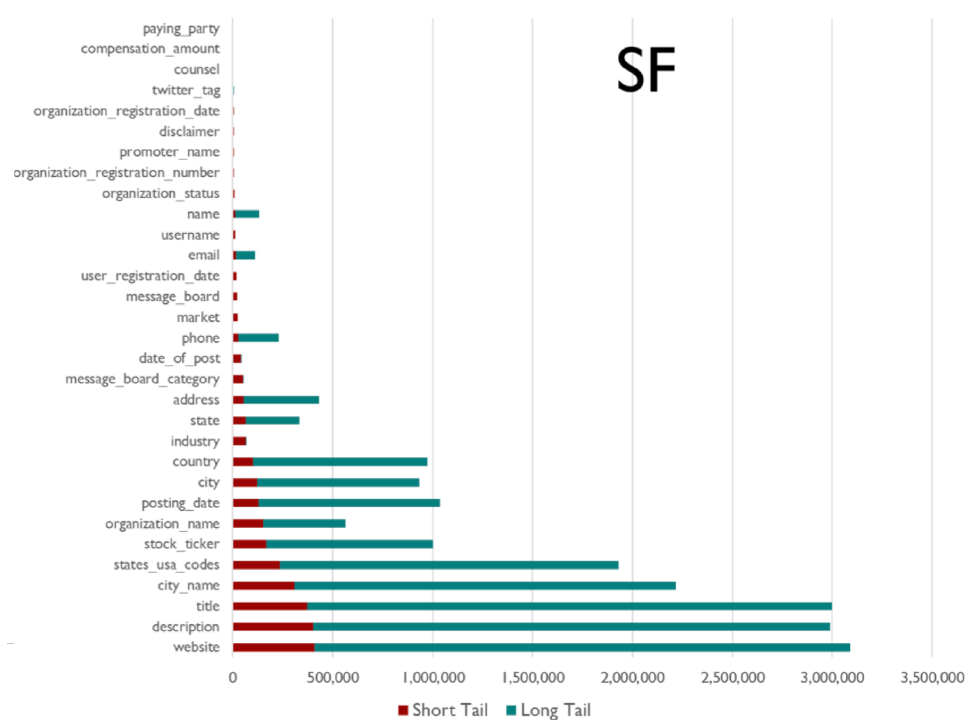
Figure 10. For the SF domain, a comparison of web page count (x-axis) such that at least one value per field (y-axis) was extracted from that website (green bar/long tail), against the short tail/red bar wherein only Inferlink extractions are